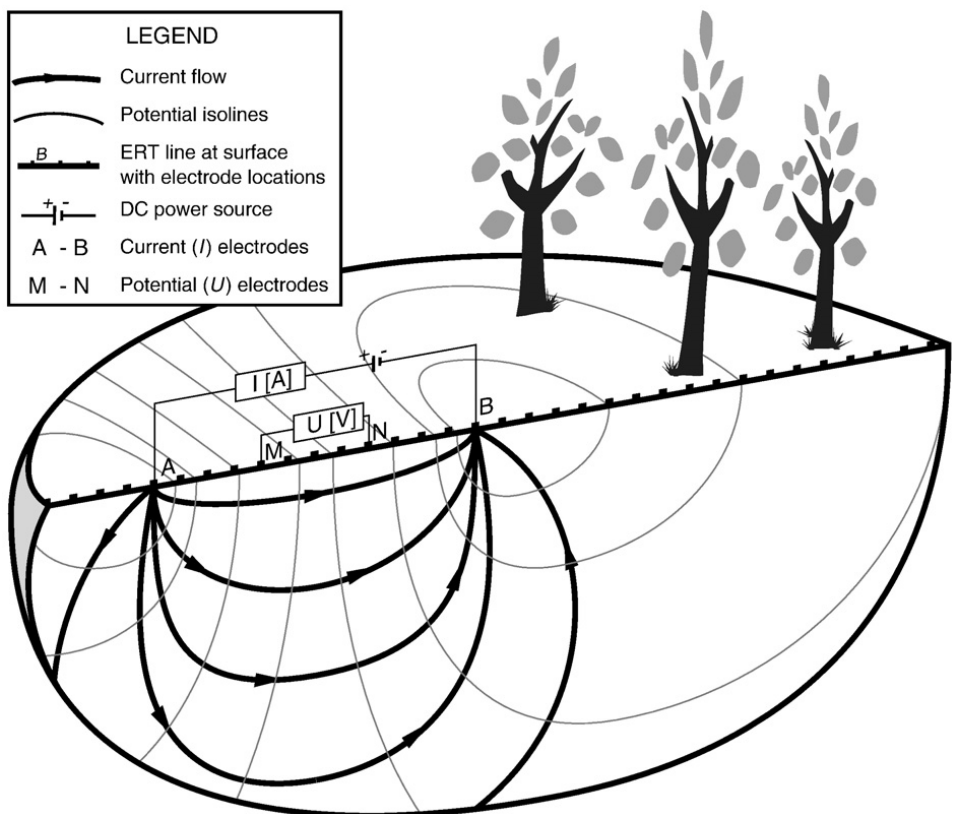
Figure 3. Schematic diagram of resistivity measurements in a homogeneous medium. By combining measurements of many electrode combinations using computer tomography, a spatial earth resistivity section is made and moisture dynamics can be captured [13].